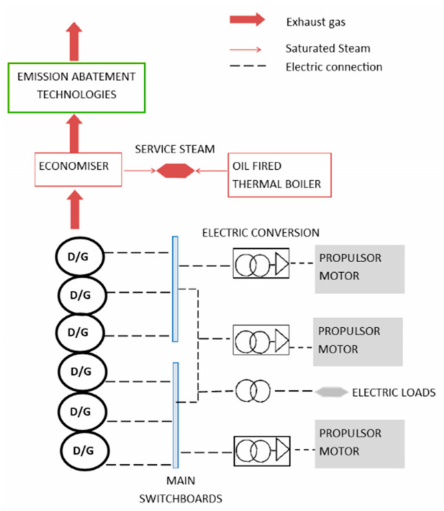
Figure 4. Cruise ship power plant configuration layout.